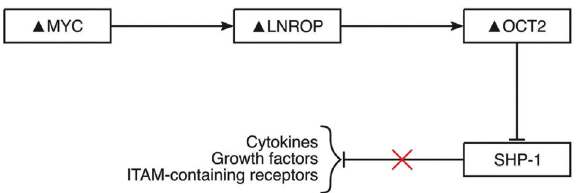
Fig. 5 Schematic representation of the lines of interaction studied in this article. The MYC-regulated lncRNA LNROP promotes the expression of the transcription factor OCT2 and acts as a key intermediary between MYC and OCT2. SHP-1, a transcription factor with anti-proliferative activity in B cells, is downregulated by